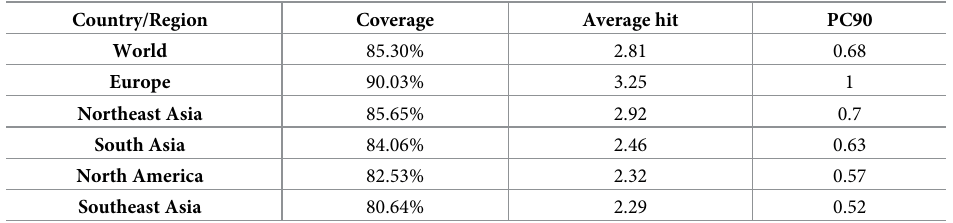
Table 7. Population coverage results of the epitopes using IEDB